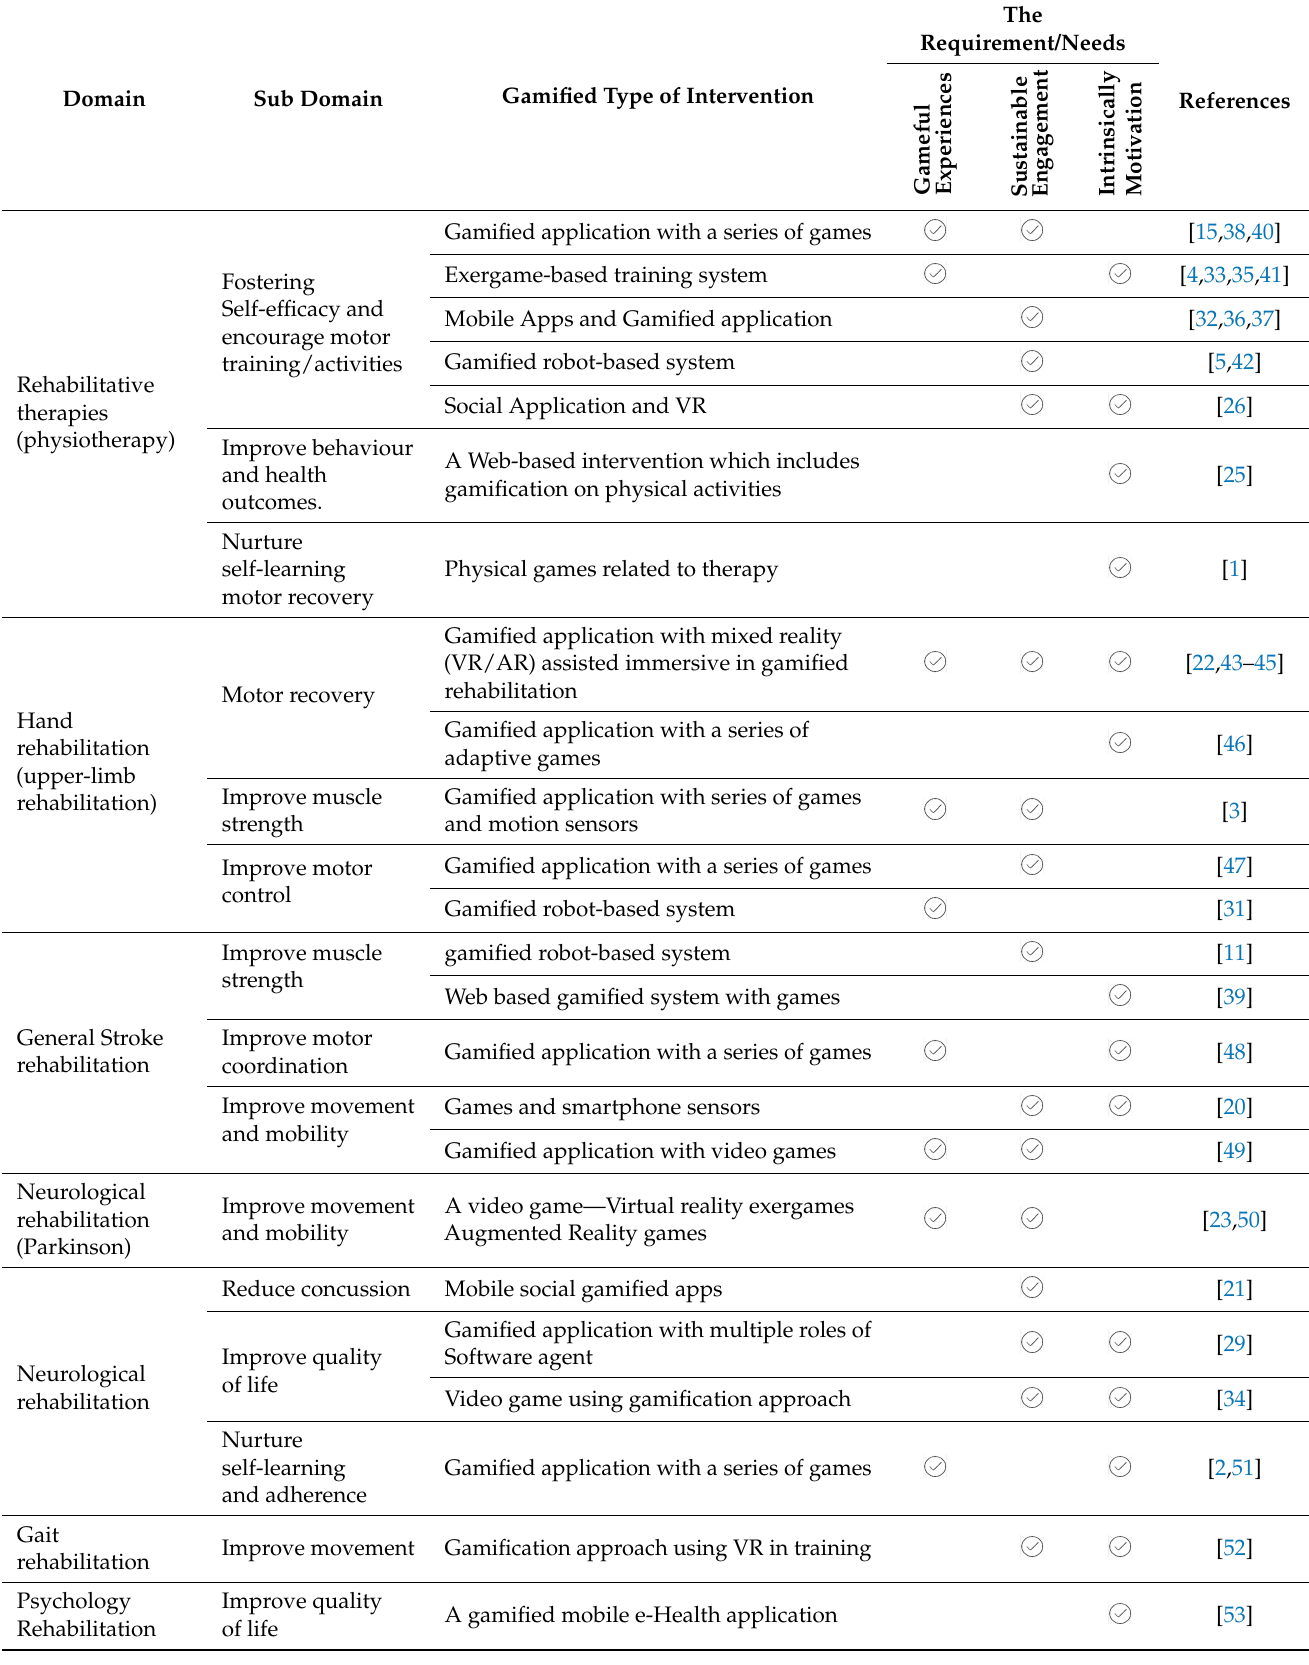
Table 1. Mapping gamified type of interventions with the requirement of gamification in rehabilitation training.